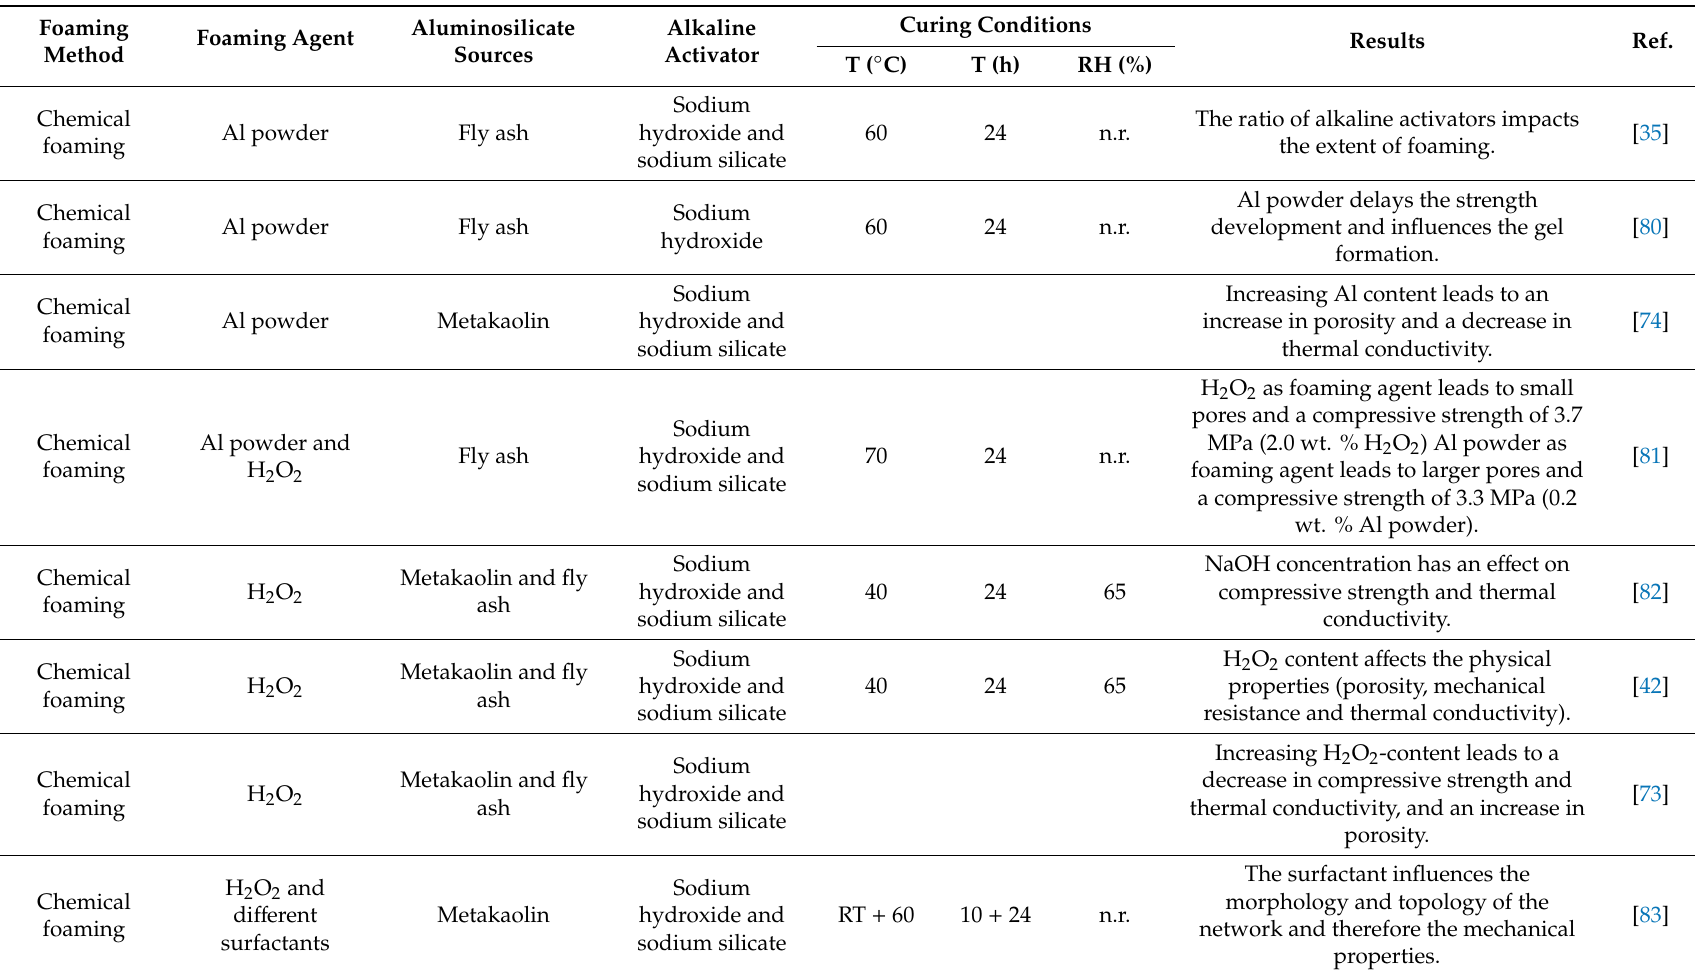
Table 2. Overview of foaming methods for geopolymer